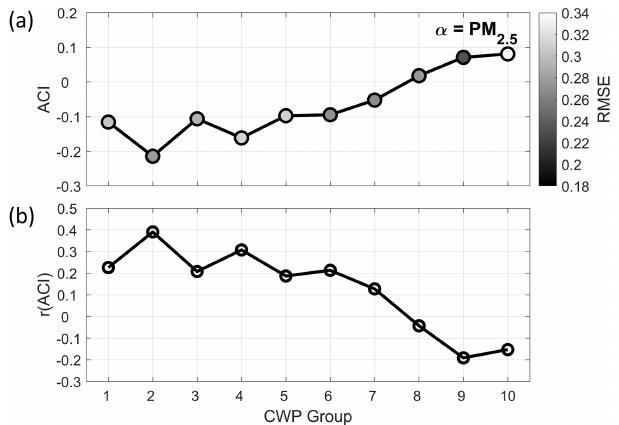
Figure 6. (a) Aerosol–cloud interaction (ACI) estimated values, computed for the cloud effective radius (CER) in the different CWP groups by applying PM 2 . 5 concentrations as aerosol proxies. The shading in (a) represents the RMSE. (b) The correlation coefficients between PM 2 . 5 and CER are